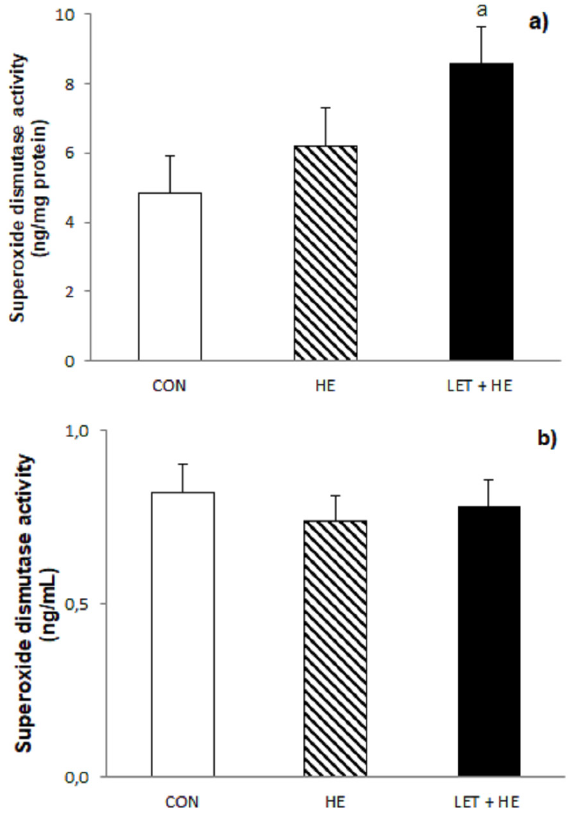
Figure 4. a) Vastus intermedius muscle and b) plasma superoxide dismutase activities of the groups. Data are expressed as mean ± SD. a P < 0.05 compared to the CON group. CON: Control group, HE: High-intensity eccentric exercise group, LET + HE: Low-intensity eccentric exercise training plus high-intensity eccentric exercise